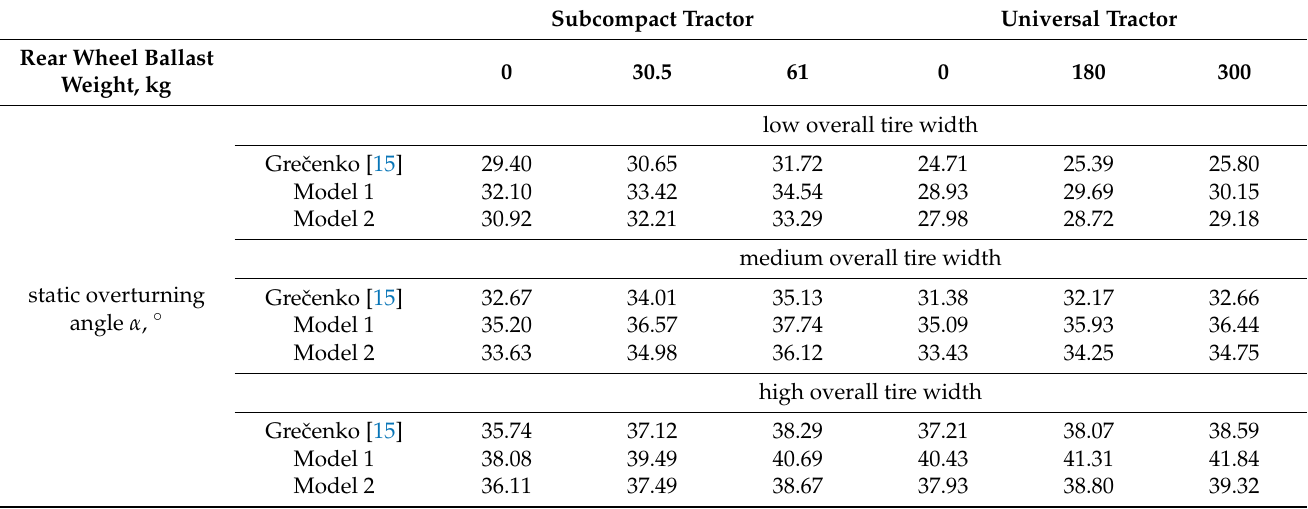
Table 4. Data calculated according to [15], Model 1, and Model